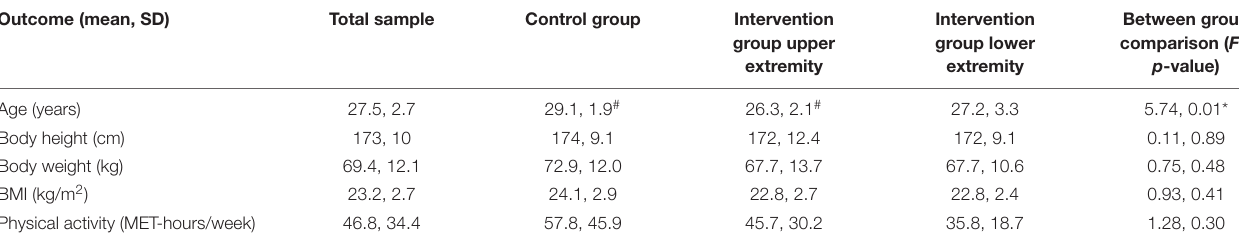
Intervention Between group group upper group lower comparison ( F -, extremity extremity p